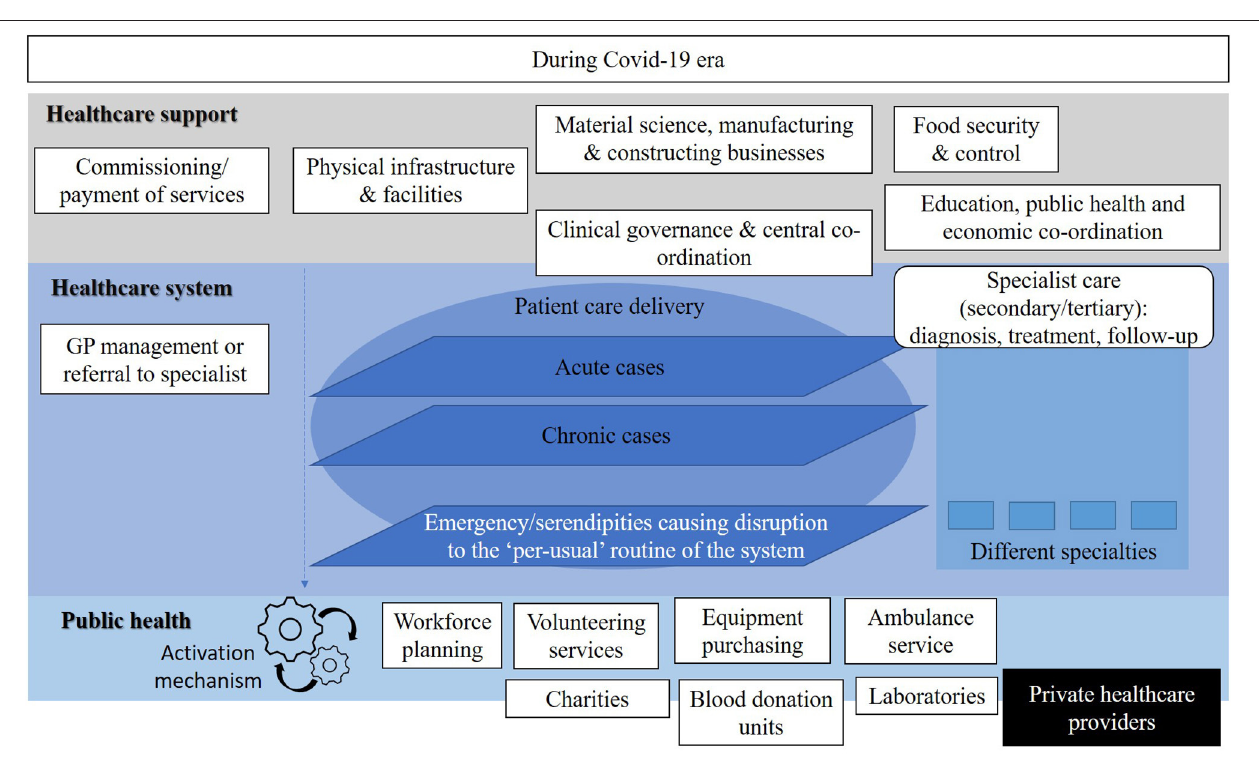
FIGURE 2 | The ‘acute’ phase of the Cypriot healthcare system following the introduction of the COVID-19 pandemic.